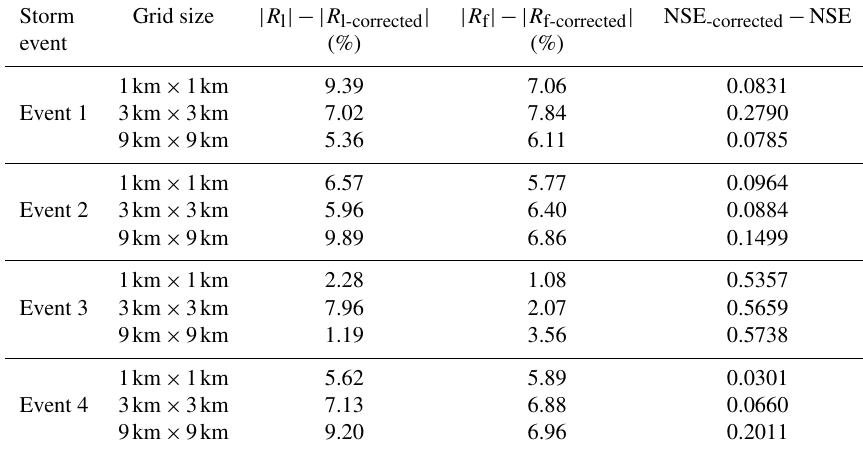
Table 11. The system errors from the rainfall simulations for four storm